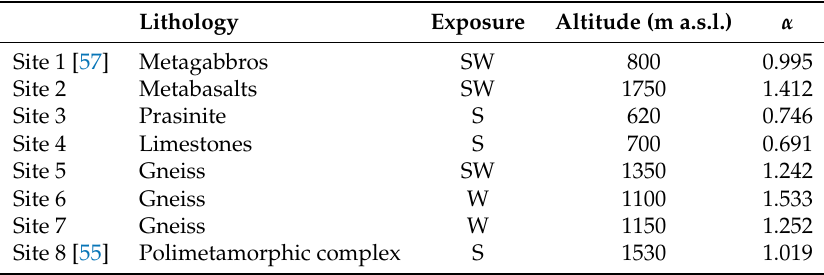
Table 1. Main characteristics of the test sites and correspondent α